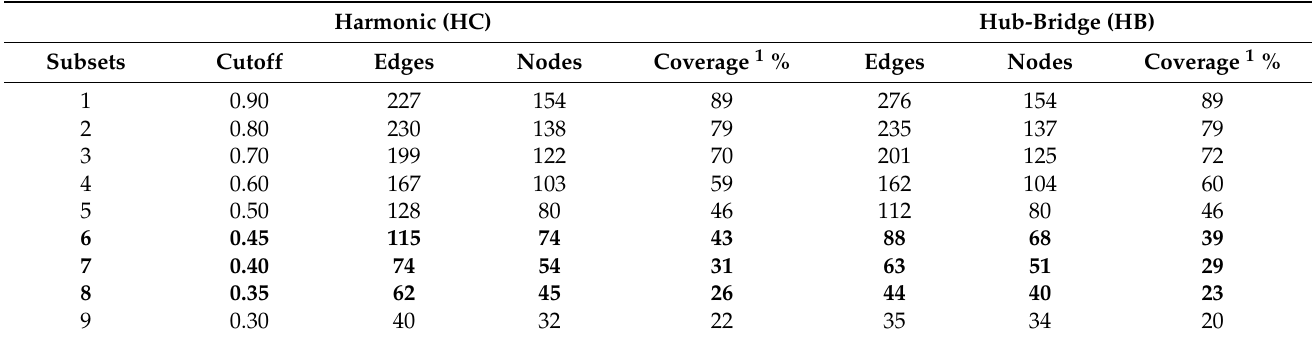
Table 3. ABFP subsets extracted from the HSPN model made up of 174 nodes and 325 edges using the scaffold extraction algorithm from the StarPep toolbox. The harmonic and hub-bridge centralities were applied for the reduction step at different similarity cutoff